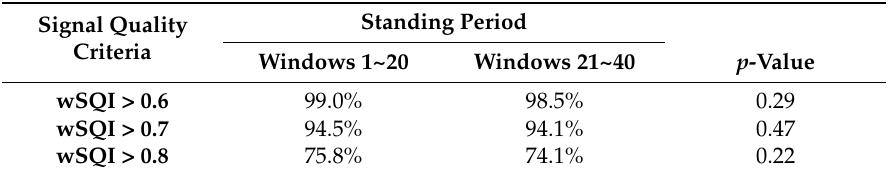
Table 6. Mean coverage [%] for wSQI ranges, depending on the standing duration. We determined the p -values by a t -test with the null hypothesis that the mean wSQI coverage was not different between windows 1~20 and windows 21~